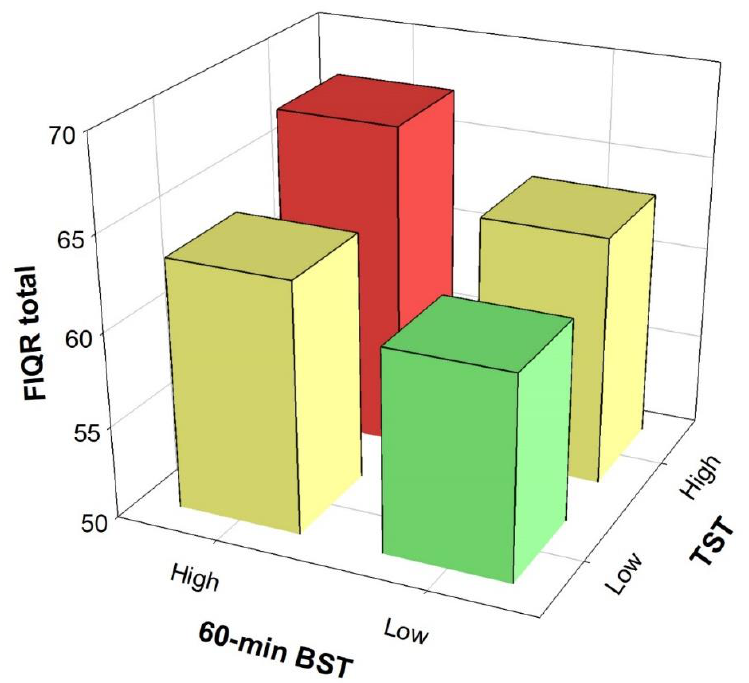
Figure 2. Combined effect of total sedentary time (TST) and 60-min bouted sedentary time (BST) on overall impact of the disease. Bonferroni’s post-hoc differences between the Low TST + Low BST and High TST + High BST groups ( P = 0.002). Analysis controlled for age, bouted moderate-to-vigorous physical activity, overall physical fitness and accelerometer wear time. FIQR, Revised Fibromyalgia Impact Questionnaire.